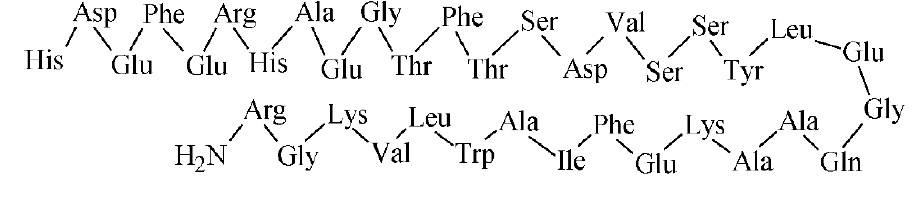
Figure 15. The AA sequence of GLP-1. Table 10. Summary of radiolabeled exendin analogues for GLP-1 receptor-positive tumor imaging over past 3 years. Composition of Studied Compounds